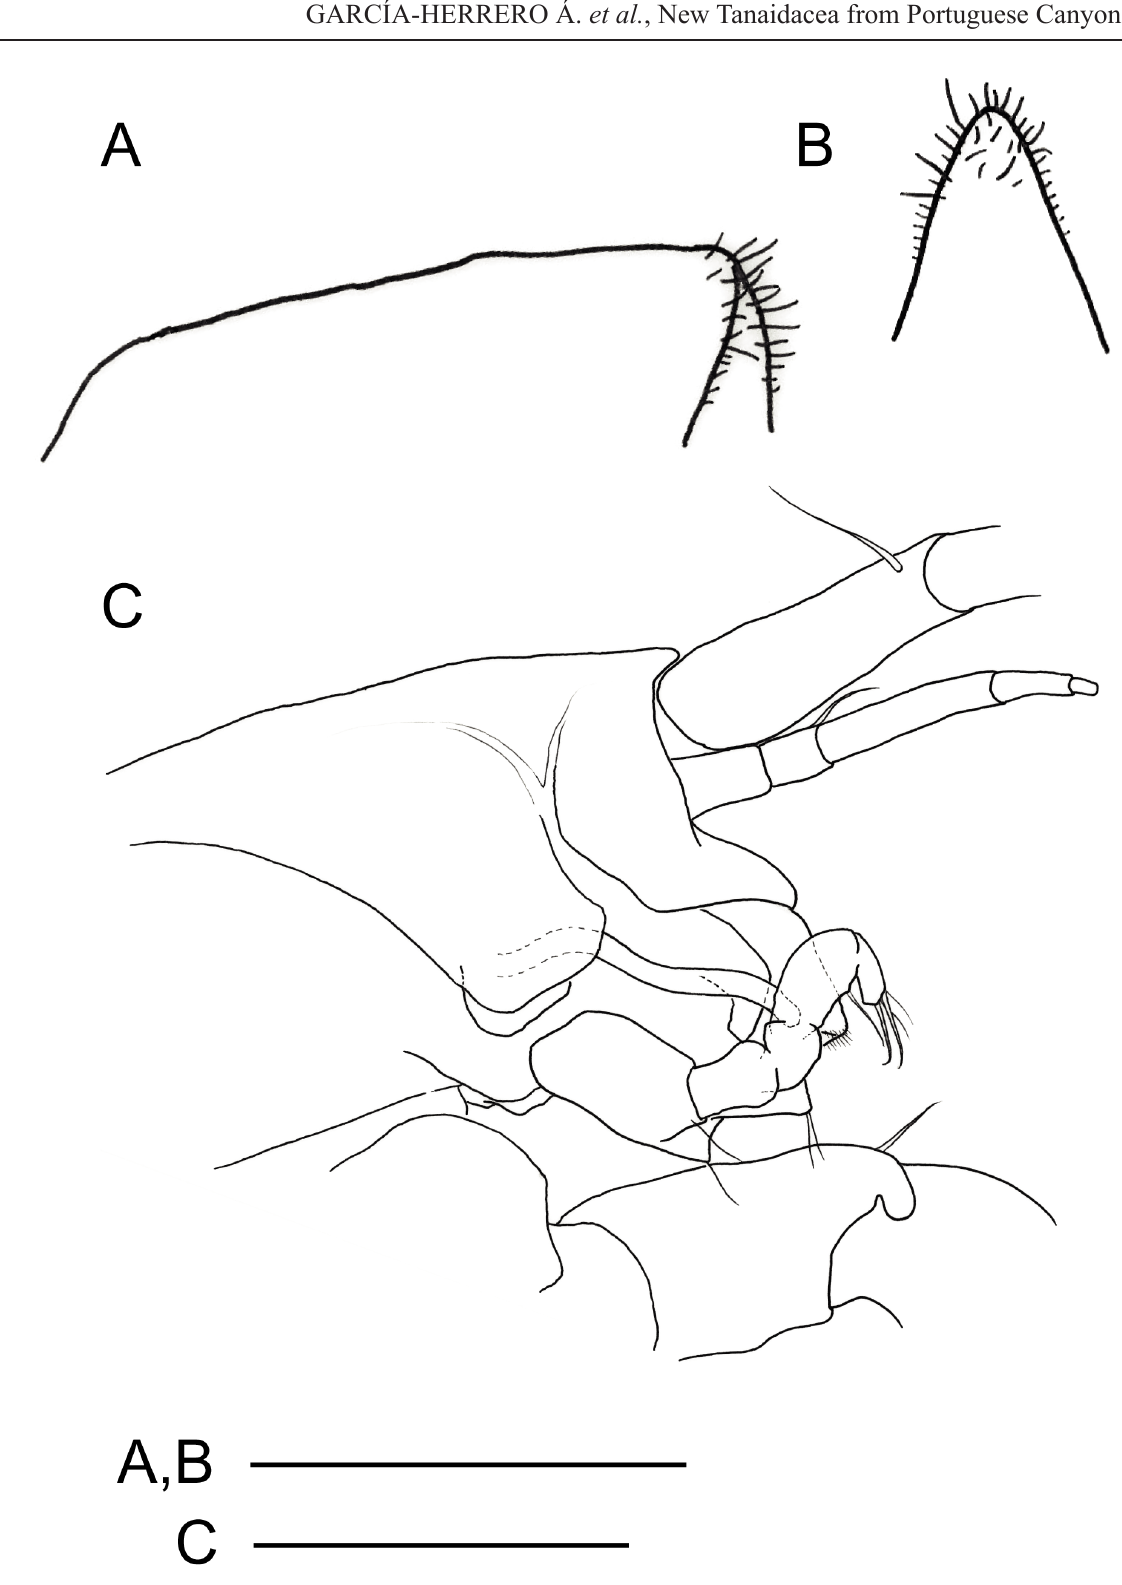
Fig. 3. Paranarthrura cousteaui sp. nov. Dissected paratype, adult, ♀ (DBUA0002189.03). A . Labrum in lateral view. B . Labrum in ventral view. C . Relative position of mouthparts (right cheliped removed). Scale bars: A–B = 50 μm; C = 100